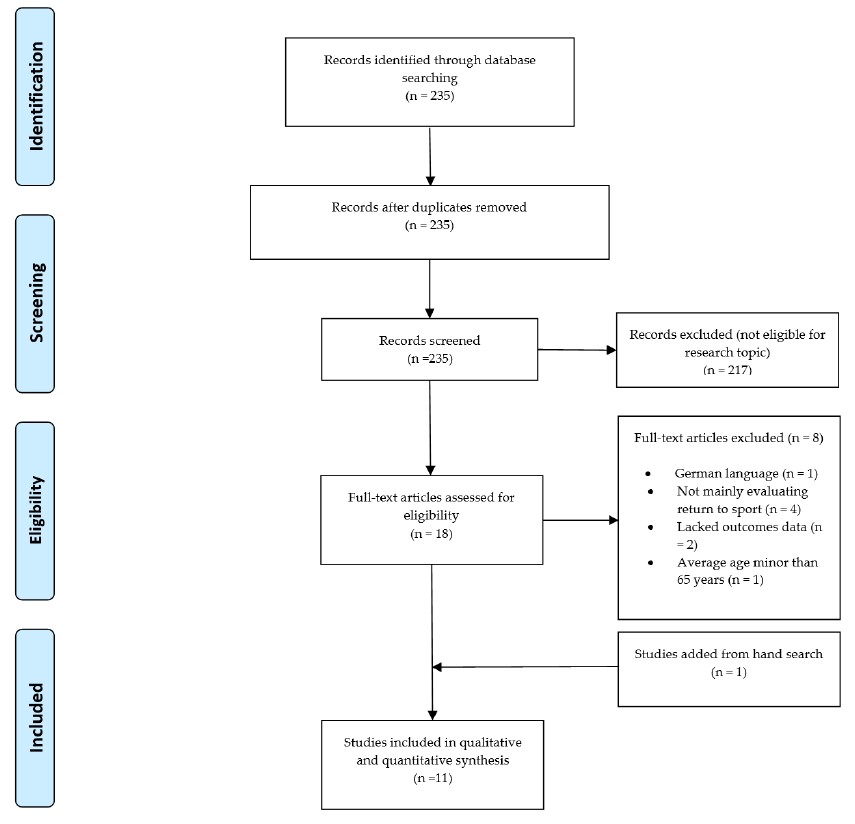
Figure 1. PRISMA flow-chart of included studies.